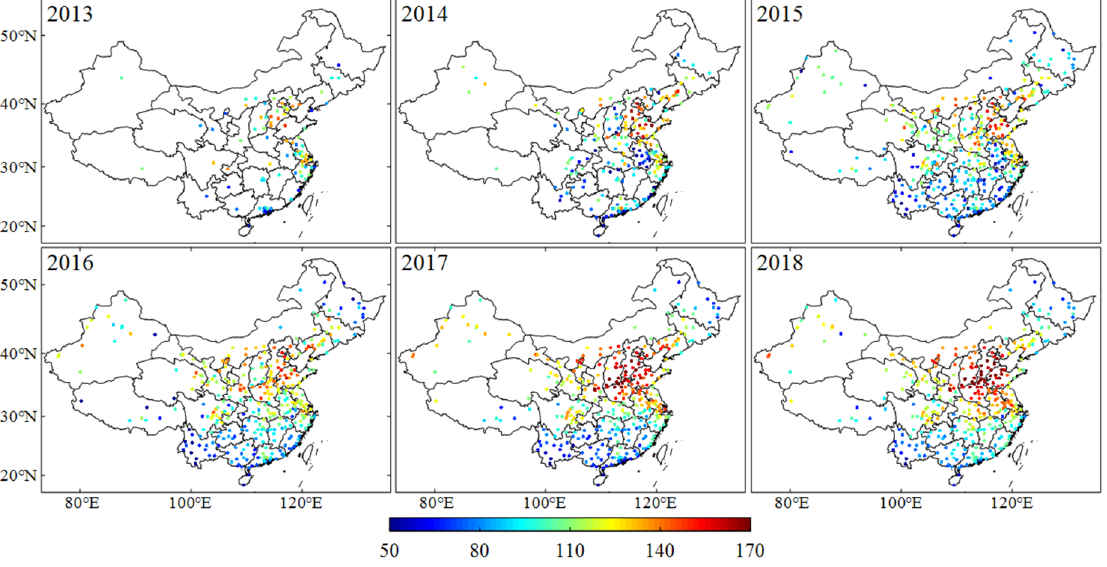
Figure 11. Annual mean of daytime maximum 8-h O 3 over the mainland of China during the summers of 2013–2018.